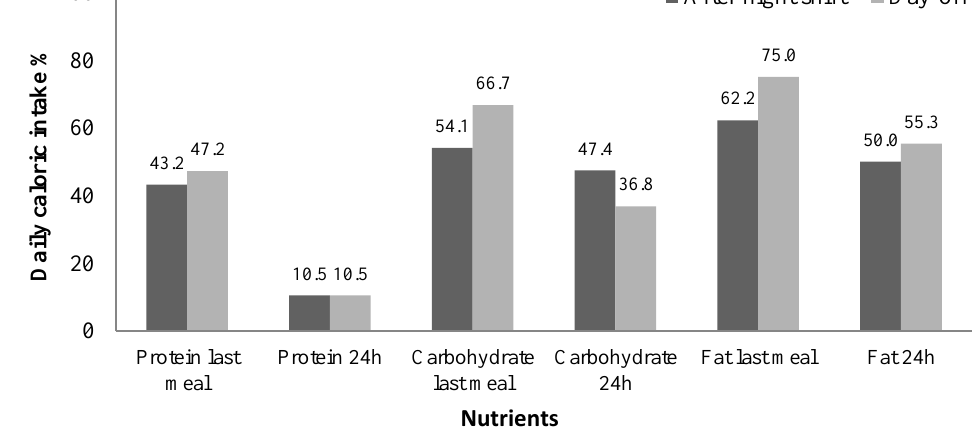
Figure 3. Percentage of participants with inadequate daily macronutrient intake for 24 h period and last meal before bed, after night shift ( n = 30), and on day-off ( n = 22). t -test, p > 0.05. There was also no difference in total caloric intake after a night shift in comparison to day-off (1801 kcal vs. 1645.8 kcal, t -test p = 0.38). However, the proportion of calories